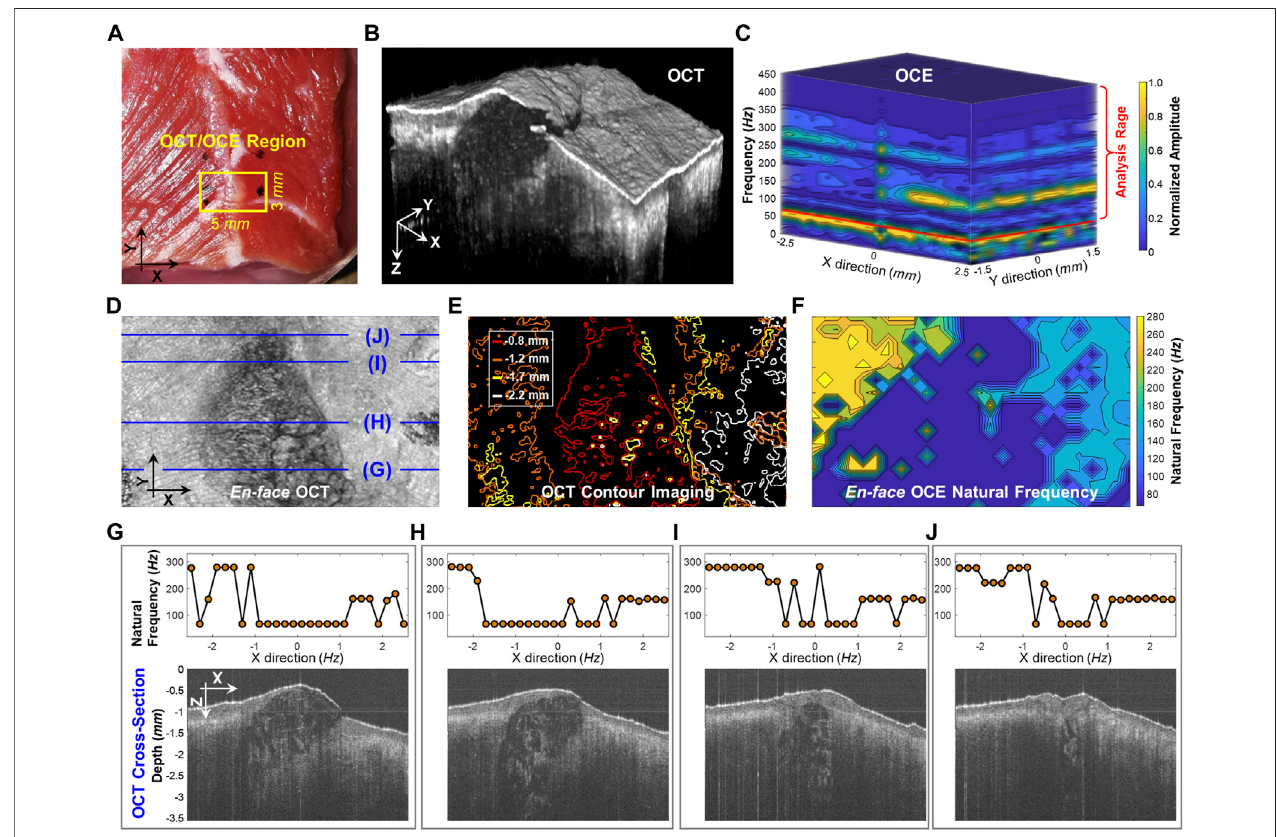
FIGURE 5 | Spatial assessment of the dominant natural frequency ( f n ) distribution in a beef shank sample. (A) Top view photo of the beef shank sample. The boundary of the beef shank sample was sealed using 2% agar in a Petri dish with an inner diameter of 38 mm and a height of 13 mm. The small window shows the regions (5 × 3 mm) for both the optical coherence tomography (OCT) structuralimaging and the optical coherence elastography (OCE) natural frequency measurement. (B) OCTvolumescanforthebeeftissuesample. (C) Normalizedoscillationfrequencyspectruminthe X and Y directions.The f n foreachmeasurementpositionwas then estimated in the range of 70 – 450 Hz. (D) and (E) show the en face OCT imaging and the corresponding contour maps at different depths (0.8, 1.2, 1.7, and 2.2 mm). (F) Spatial distribution of natural frequency ( f n ). (G – J) Comparison between the f n values and the OCT cross-sectional structures at the X-Z planes registered in (D)